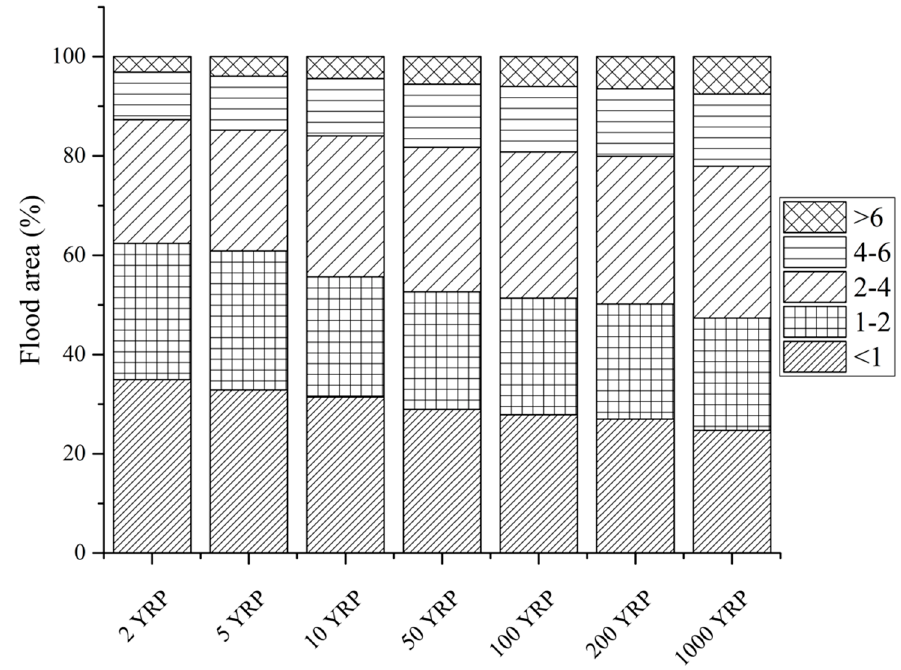
Figure 10. Flooding area percentages according to the classification scheme for inundation water depth (unit: meter), for different YRPs in the study area.